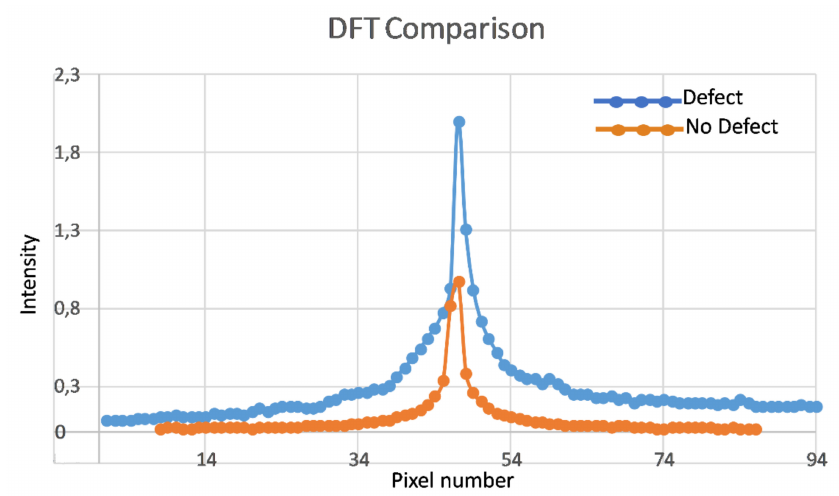
Figure 14. Comparison between the DFT amplitude spectra shown in Figure 12d or Figure 13d.